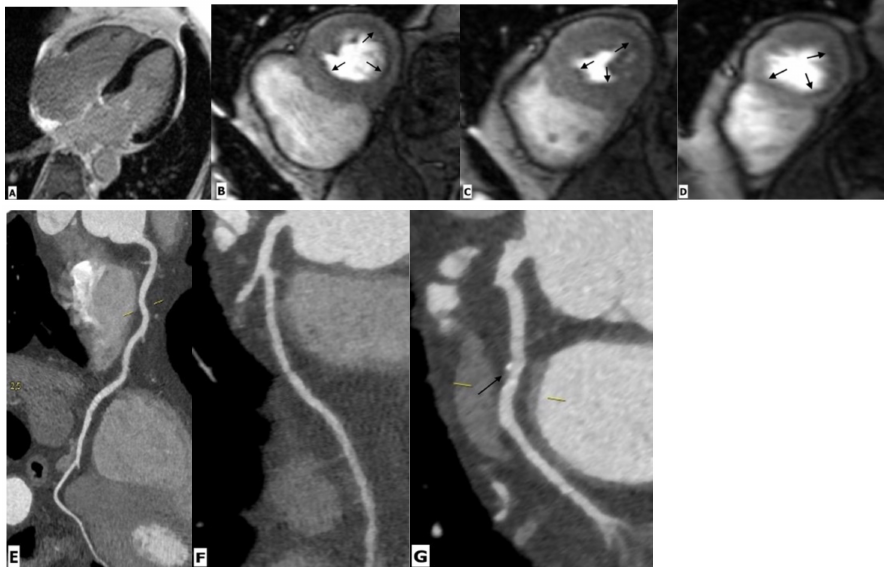
Figure 5. Cardiac magnetic resonance imaging in a 65-year-old HIV-infected male patient with microvascular coronary dysfunction. ( A ) Mid-ventricular short-axis late gadolinium enhancement image showing no ischemic pattern. Stress CMR was performed via regadenoson administration. ( B – D ) Stress protocols images of three ventricular slices (basal, mid-ventricular, and apical slices) show diffuse subendocardial hypoperfusion (arrows) due to microvascular dysfunction. ( E – G ) Multiplanar reformatted contrast-enhanced computed tomography images showing the right coronary artery (RCA), left anterior descending artery (LAD), and left circumflex artery (LCx), respectively. RCA and LAD are normal without any atherosclerotic diseases. LCx shows focal mixed plaque causing minimal luminal stenosis